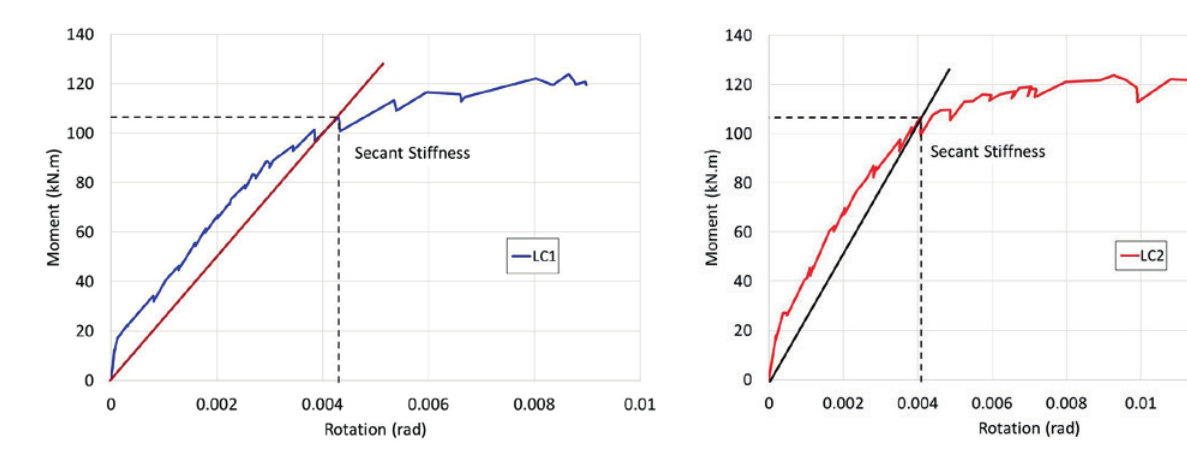
Figure 21 – Moment-rotation curve: specimens LC1 and LC2 40